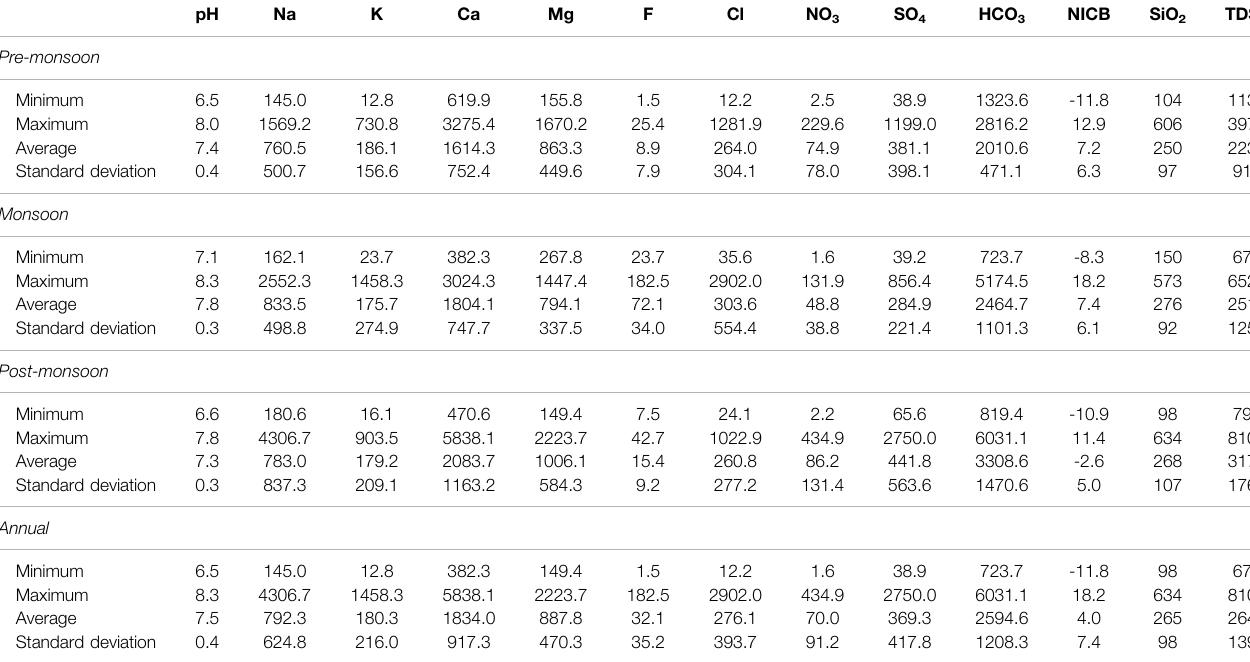
TABLE 2 | Statistics of major ion compositions of the Ramganga River and its tributaries (all data in µM except pH, total dissolved solids, TDS (in mg/l), and normalized inorganic charge balance, NICB (in %). pH Na K Ca Mg Pre-monsoon